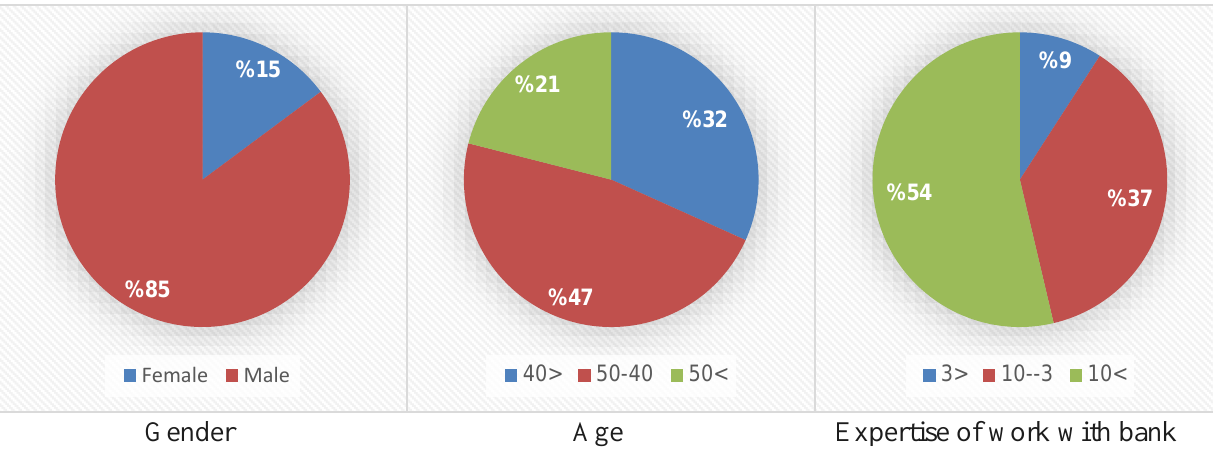
Fig. 2. Personal characteristics of the